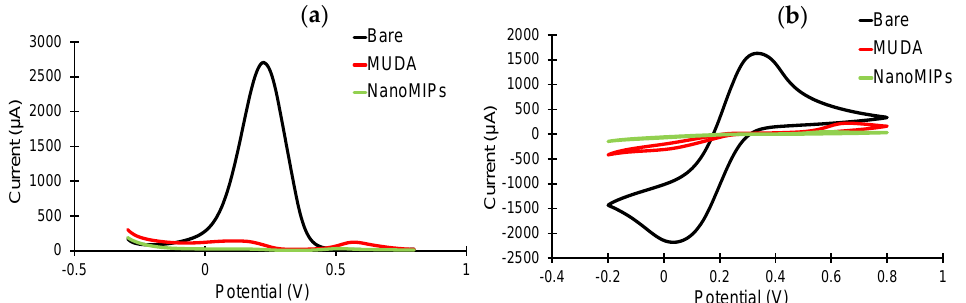
Figure 6. ( a ) Square-wave and ( b ) cyclic voltammograms confirm the immobilization of the nanoMIPs after SAM formation on the gold surface. All measurements were recorded using 10 mM K 3 (Fe(CN) 6 ) in 0.1 M KCL at room temperature. All the represented voltammograms are the result of the average of three measurements.